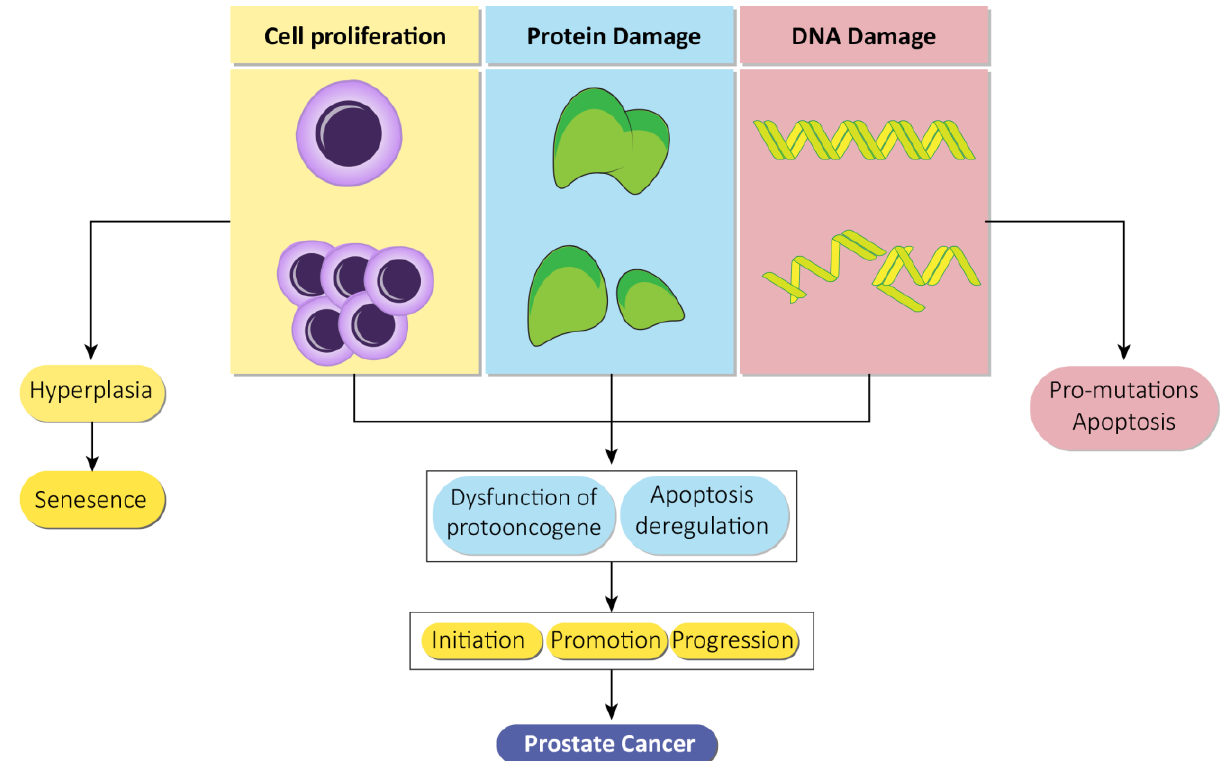
Figure 2. Prostate cancer based on a genotoxic mechanism. Proliferation of cells, damage to proteins, and genetic machinery individually lead to an individual consequence in the form of hyperplasia, cellular senescence, and apoptosis. However, in combination, these lead to multiple effects such as evading repair, protooncogene dysfunction, and apoptosis deregulation that subsequently leads to initiation, promotion, and progression of prostate